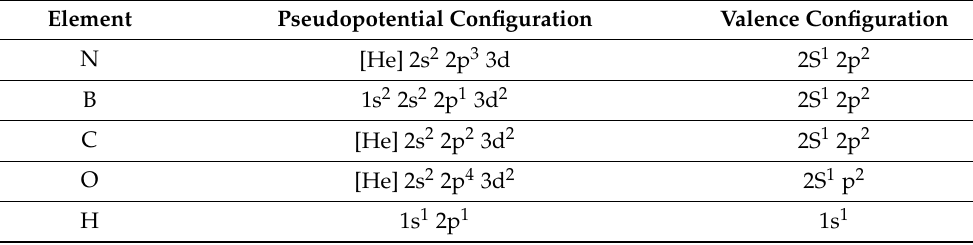
Table 2. Configurations of Pseudopotentials used in this work.